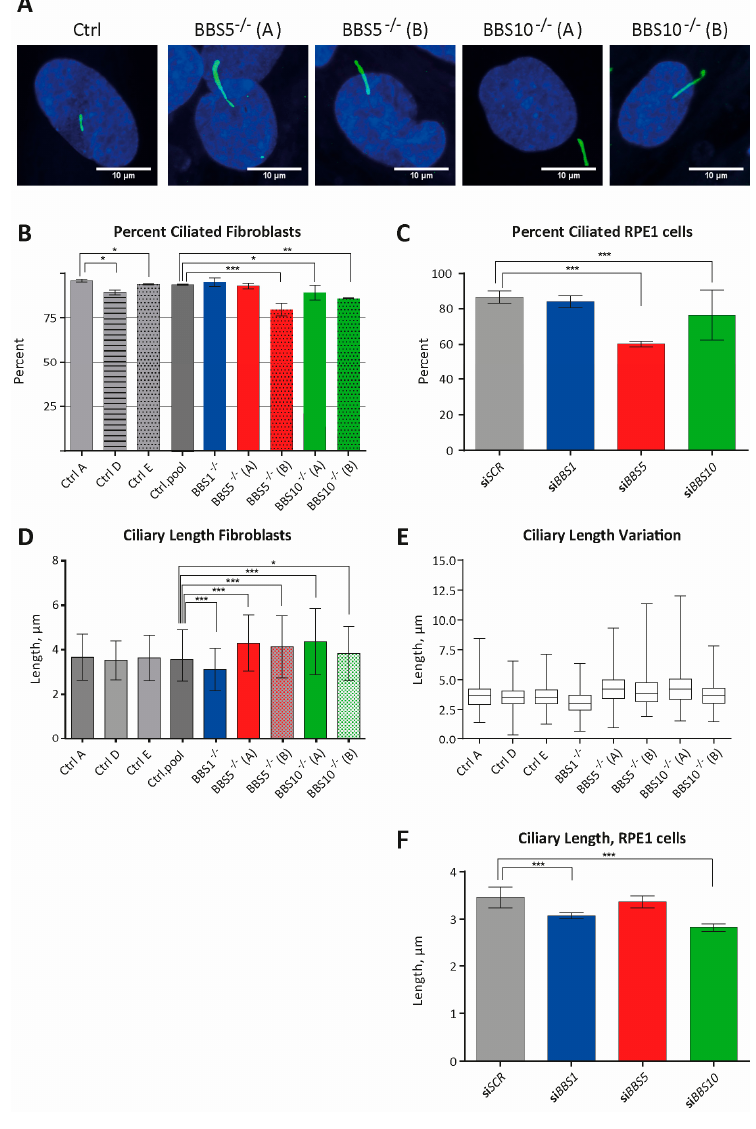
Figure 1. Investigation of the primary cilium in fibroblast obtained from patients with bardet biedl 1 syndrome (BBS) and in the hTERT-immortalized retinal pigment epithelial cell-line, (RPE-1) trans- fected with small interfering RNA (siRNA) against the BBS genes. ( A ) IFM analysis of primary cilia. Primary cilia were labeled with anti-ARL13B antibody (green). Nuclei were visualized with DAPI staining (blue). Controls (Ctrl, here CtrlD) are also shown. Scale bars 10 µ M. ( B ) Percentage of patient fibroblasts with cilia. Compared to percentage of ciliated cells in a pool of control fibroblasts (Ctrl.pool = CtrL.A + Ctrl.D + Ctrl.E; 92.60%, n = 798 cells), the percentage of ciliated cells was significantly lower in BBS5 − / − (B) (79.54%, n = 308 cells, *** p =5.13 × 10 − 10 ), BBS10 − / − (A) (89.16%, n = 369 cells, * p = 0.0494) and BBS10 − / − (B) (85.78%, n = 225 cells, ** p = 0.0015) fibroblasts. No sig- nificant differences were observed for BBS1 − / − (94.98%, n = 239, p = 0.202) and BBS5 − / − (A) (92.77%, n = 249, p = 0.9301) compared to the pool of control fibroblasts. There was a significant difference in percentage of ciliated cells between the three controls (Ctrl). The percentage was significantly lower in Ctrl.D (89.18%, n = 305 cells) compared with Ctrl.A (95.72%, n = 234 cells; Ctrl.D/Ctrl.A: * p = 0.0054) and Ctrl.E (93.82%, n = 259 cells; Ctrl.D/Ctrl.E: * p = 0.037). No significant difference was observed between CtrlA and CtrlE (CtrlA/CtrlE: p = 0.34). ( C ) Percentage of siBBS RNA-treated RPE1 cells with cilia. The cilia were labeled with anti ARL13B antibody and nuclei were